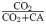
Effects of 12 weeks of exercise on myotube glucose metabolism.Satellite cells isolated from biopsies from m. vastus lateralis before and after 12 weeks of exercise were cultured and differentiated to myotubes. Oxidation and cell-associated (CA) radioactivity of [14C]glucose were measured, and total cellular uptake (CO2+CA), oxidation (CO2), and fractional oxidation (CO2CO2+CA) were determined. (A) Glucose oxidation and total cellular uptake presented as nmol/mg protein. Values are presented as means ± SEM for all participants combined (n = 18). (B) Fractional glucose oxidation. Values are presented as means ± SEM for all participants combined (n = 18). (C) Glucose metabolism relative to before exercise. Values are presented as means ± SEM for all participants combined (n = 18). *Statistically significant vs. before exercise (p < 0.05, linear mixed-model analysis, SPSS). (D) Glucose oxidation and total cellular uptake presented as nmol/mg protein in study group when separated by BMI. Values are presented as means ± SEM (n = 7 in the normal weight group and n = 11 in the overweight group). (E) Fractional glucose oxidation in absolute values in study group when separated by BMI. Values are presented as means ± SEM (n = 7 in the normal weight group and n = 11 in the overweight group). (F) Glucose metabolism relative to before exercise in study group when separated by BMI. Values are presented as means ± SEM (n = 7 in the normal weight group and n = 11 in the overweight group). *Statistically significant vs. before exercise (p < 0.05, linear mixed-model analysis, SPSS). $Statistically significant vs. normal weight group (p < 0.05, linear mixed-model analysis, SPSS). (G) Pearson’s test of correlation between exercise-induced changes in leg press and glucose oxidation in myotubes. Δ = after exercise–before exercise. Full line represents the regression line for all donors (n = 18, Pearson’s correlation coefficient, r = 0.52, and p = 0.03), whereas stapled line represents the regression line for the overweight group (n = 11, Pearson’s correlation coefficient, r = 0.68, and p = 0.02).